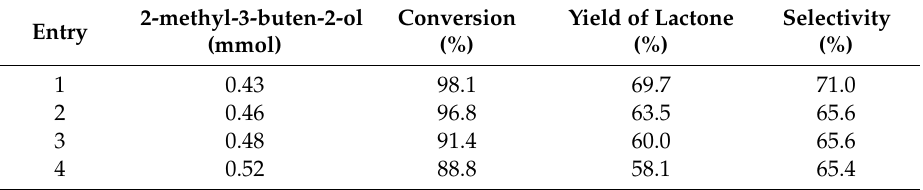
Table 1. E ff ect of substrate amount on the cyclocarbonylation of 2-methyl-3-buten-2-ol 1 . 2-methyl-3-buten-2-ol Conversion Yield of Lactone Selectivity Entry (mmol) (%) (%) (%) 1 0.43 98.1 69.7 71.0 2 0.46 96.8 63.5 65.6 3 0.48 91.4 60.0 65.6 0.52